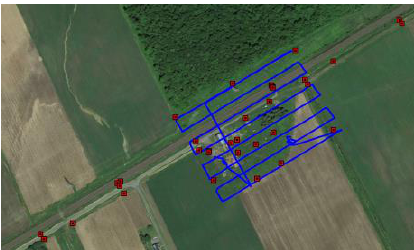
Figure 4: Ground Control Point Distribution viewed in Google Maps